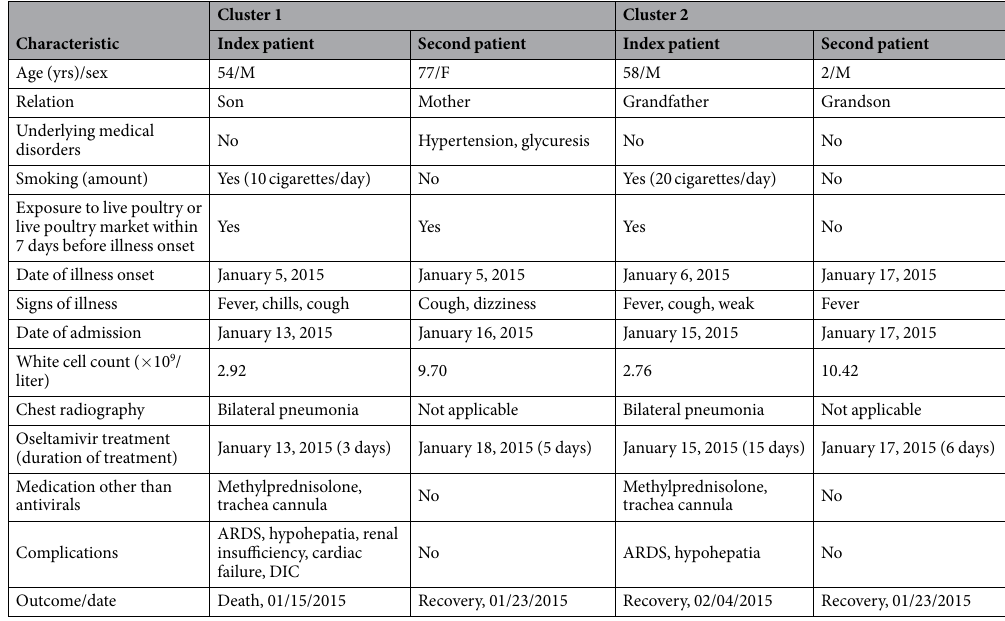
Table 1. Demographic, epidemiological, and clinical characteristics for two family clusters of H7N9 virus infection in Fujian,